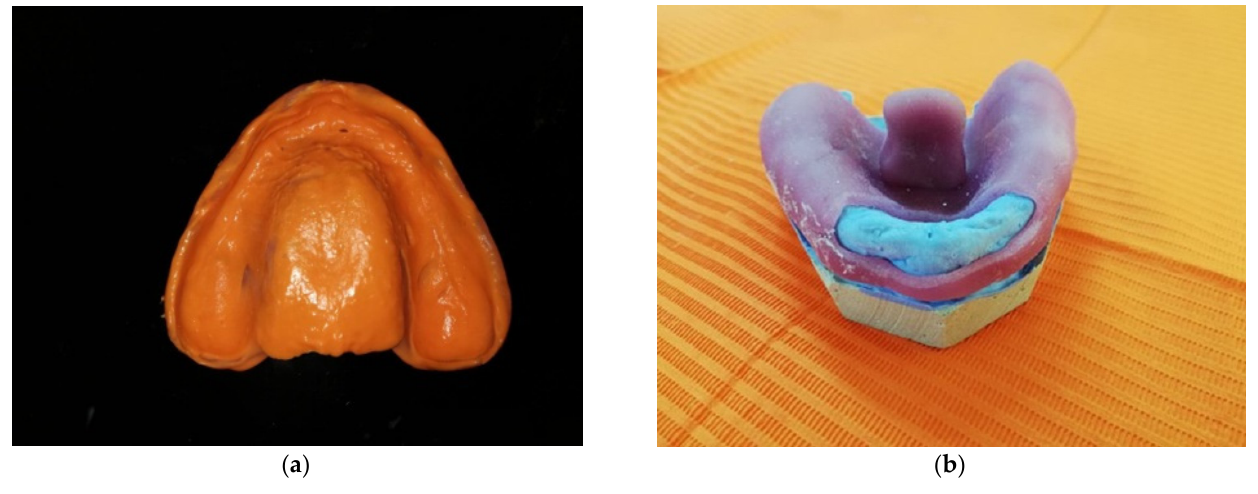
Figure 6. ( a ) Preliminary impression; ( b ) Fenestrated custom tray.